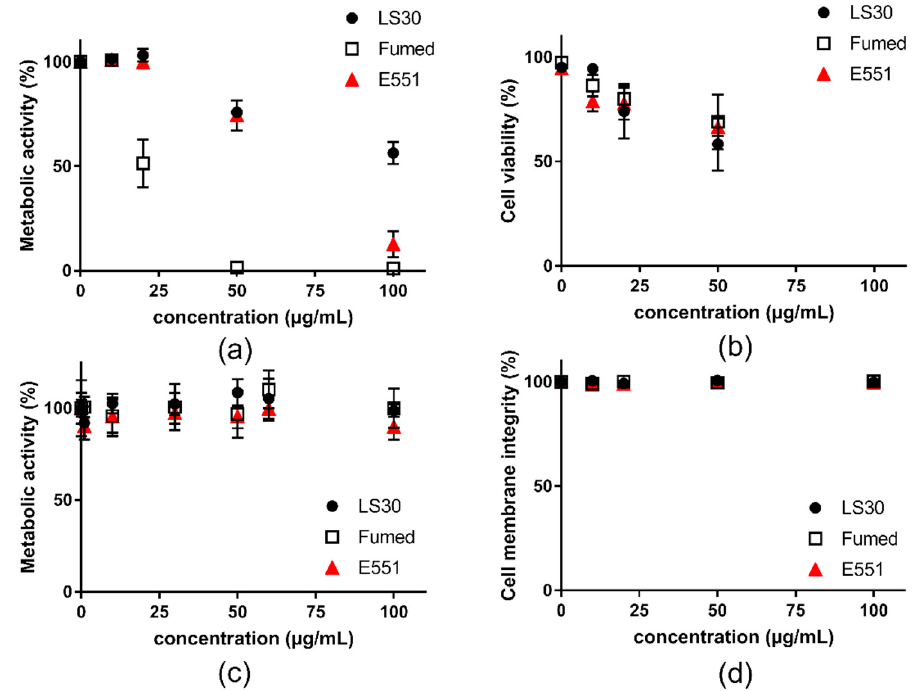
Figure 2. Cytotoxicity of SiO 2 particles, acute exposure for 24 h to SiO 2 particles. ( a ) metabolic activity of RAW264.7 cells assessed via the WST-1 assay; ( b ) cytotoxicity assessed in RAW264.7 cells via trypan blue staining; ( c ) metabolic activity of Caco-2 / HT29-MTX cells assessed via the WST-1 assay; and, ( d ) membrane integrity of Caco-2 / HT29-MTX cells assessed via the LDH assay. Mean ± standard deviation of five replicates (n=5).